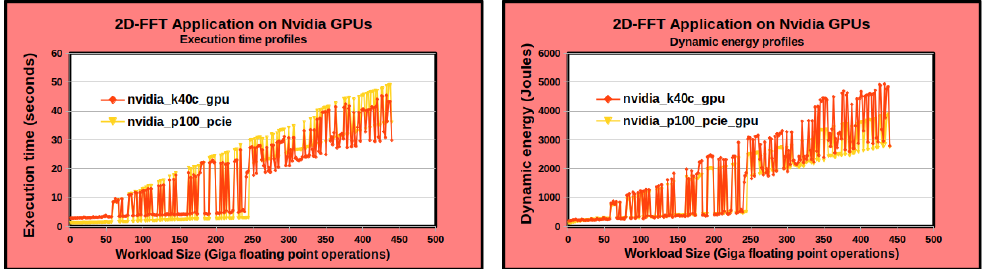
Figure 8. Plots of the execution time and dynamic energy profiles for the 2D-FFT application. The application computes a 2D discrete Fourier Transform of a dense square complex signal matrix of size n × n on two GPUs, an Nvidia K40c GPU and an Nvidia P100 PCIe GPU (Figure 1). The workload size is shown in Giga floating point operations.